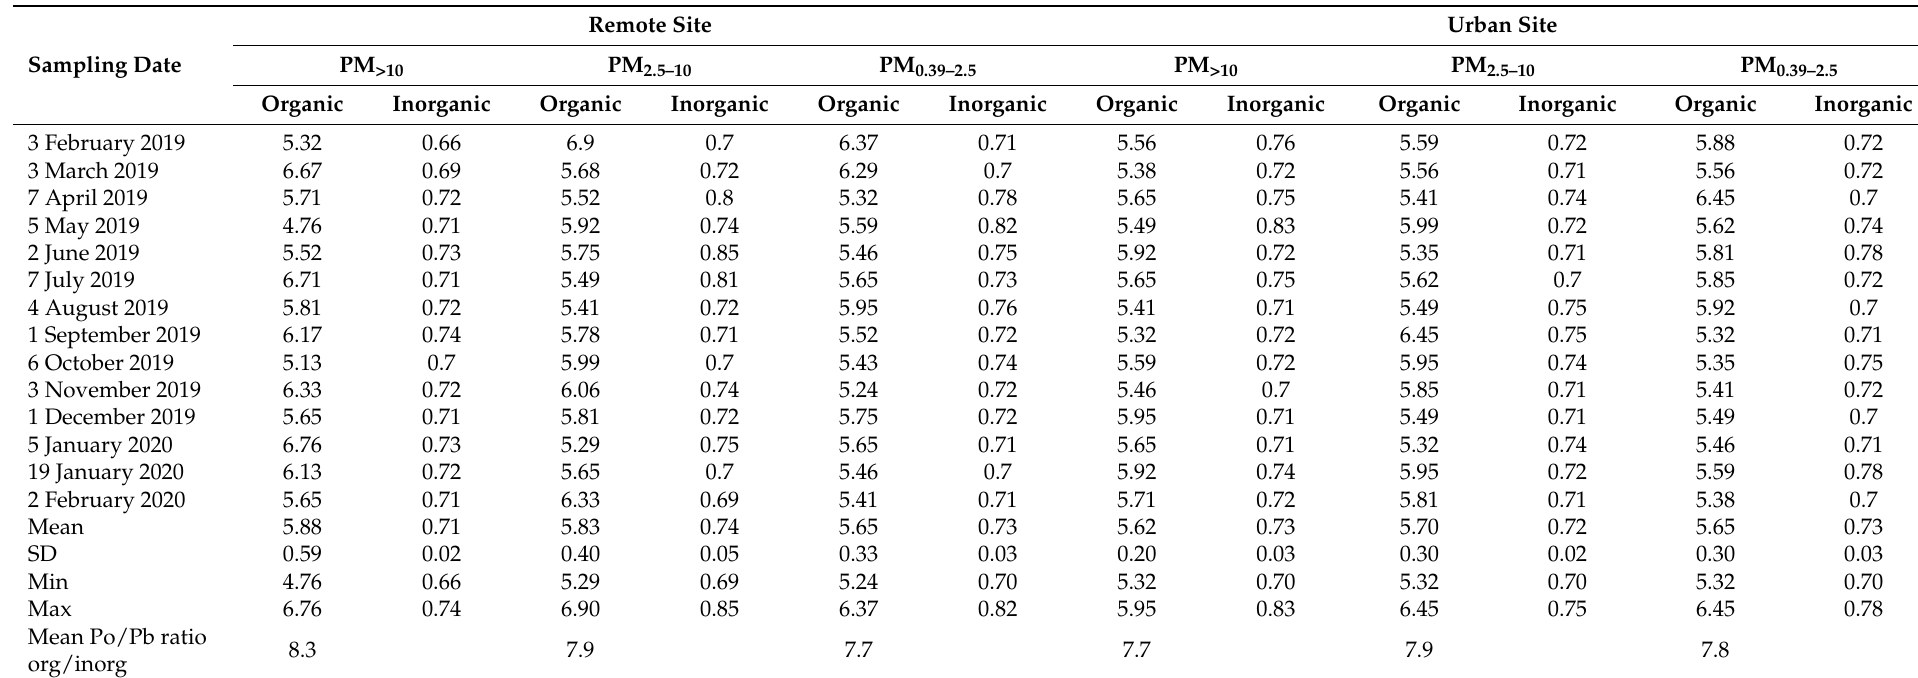
Table 4. Polonium/lead ( 210 Po/ 210 Pb) activity concentration ratios in the organic and inorganic components of the size fractionated